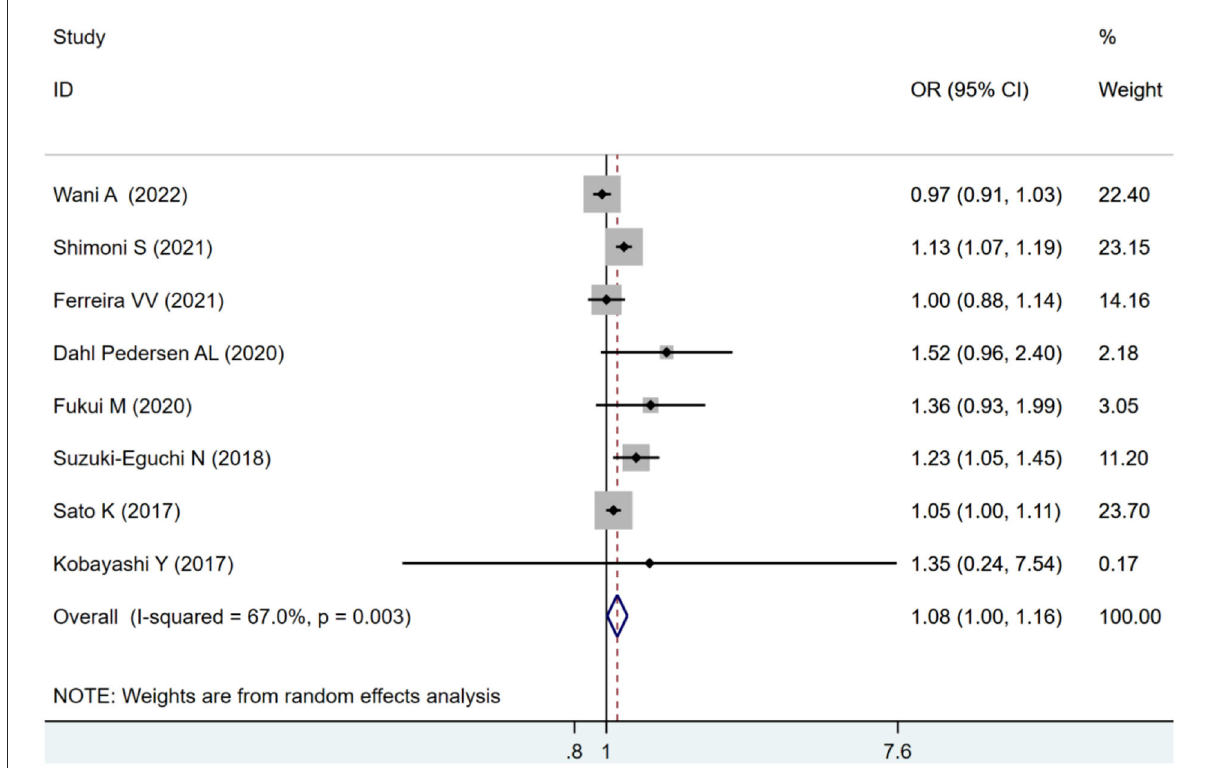
FIGURE2 Forest plot demonstrating the association between LVLS and combined ACM and MACE in Patients with AS undergoing